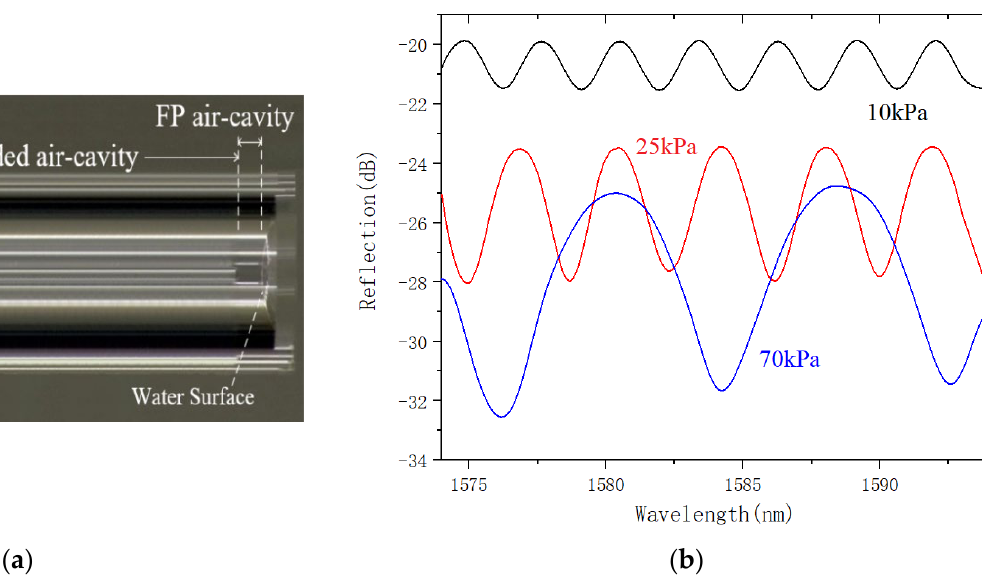
Figure 3. ( a ) Micrograph of sample-3 in water. ( b ) Reflection spectrum of the sensor at different pressures.